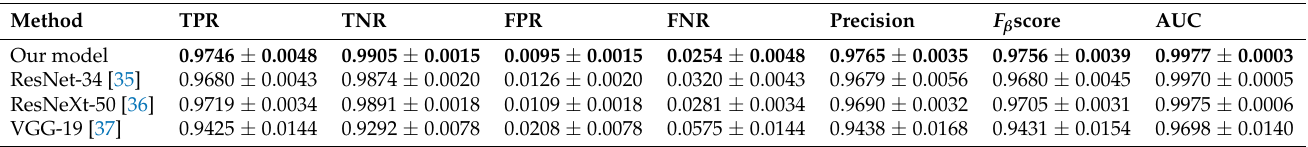
Table 5. The performance of the four models on the combination of the two public datasets by 5-fold cross-validation. Method TPR TNR FPR FNR Precision F β score AUC Our model